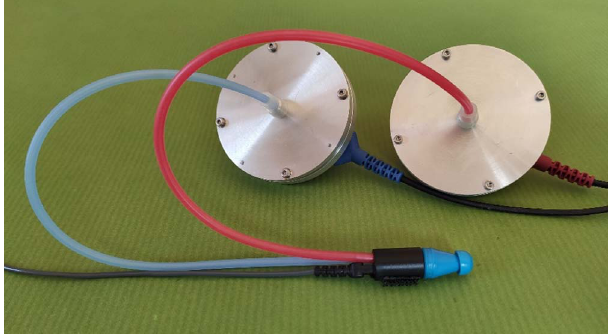
Figure 1. Picture of the two DD45 earphone transducers (top) coupled with the Etymotic ER-10B+ system (bottom) via two tubes, as part of the